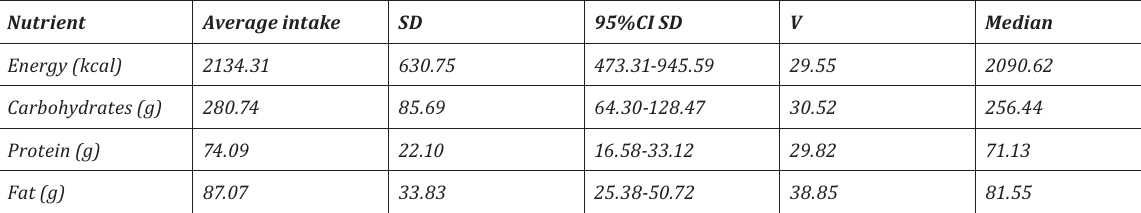
Table 4. Total energy and nutrients intake in the men